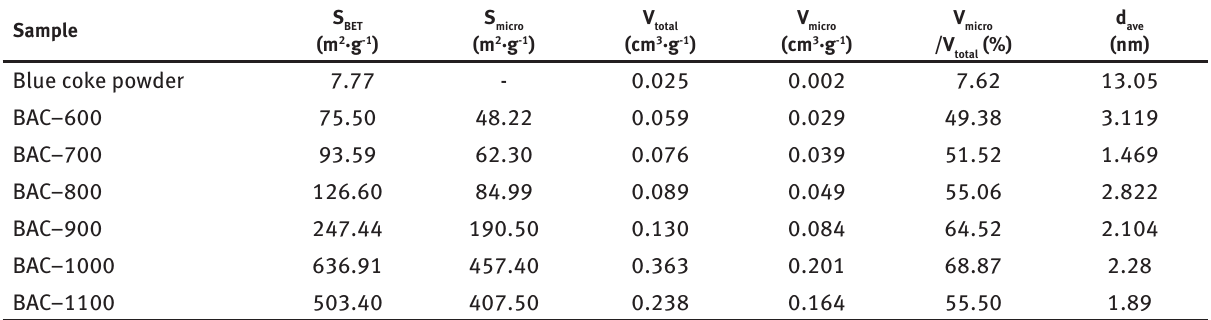
Table 2: Pore structure parameters of the BACs.